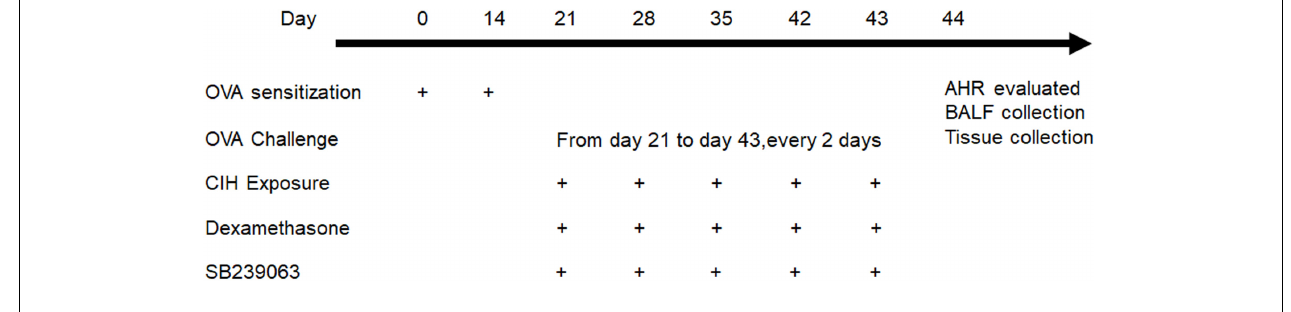
FIGURE 1 | Diagram of animal